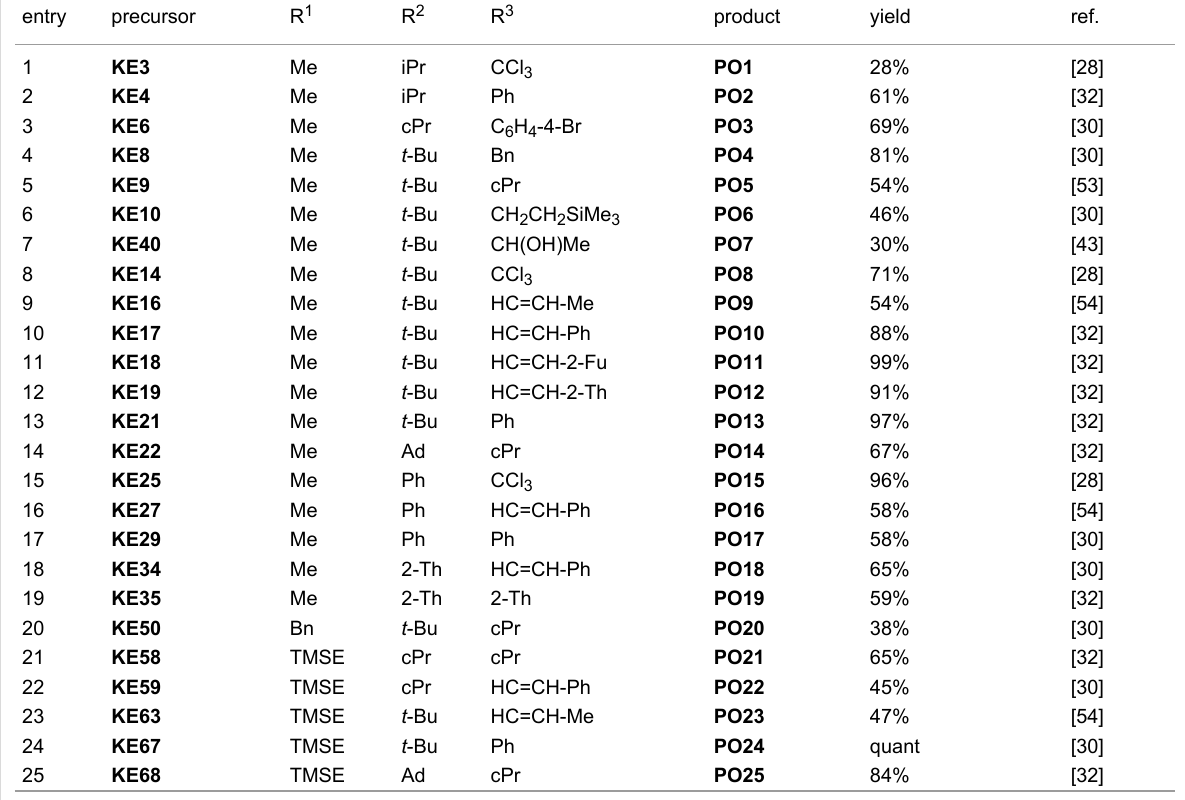
a Abbreviations: Ad = 1-adamantyl, Fu = furyl, Py = pyridyl, Th = thienyl; all alkenyl substituents are E